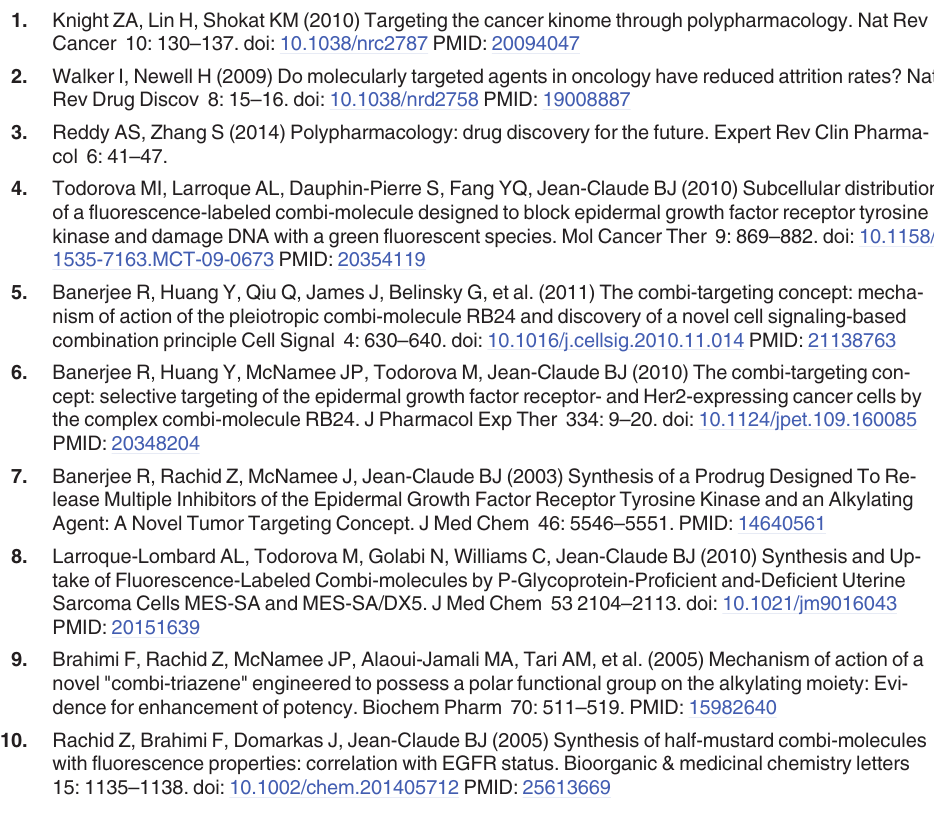
S4 Fig. Pharmacodynamics of AL776. Female Balb/c mice (n = 4) with 4T1 mammary tu- mours were treated with ( A ) 40 mg/kg of AL776 or the combination of ( B ) gefitinib + dasatinib (20 mg/kg each) compared with the vehicle control. Mice were sacrificed 1h or 24h after drug exposure and the tumours were collected, processed and inhibition of phosphorylated proteins (EGFR, c-Src, ERK1/2) was assessed using western blots.